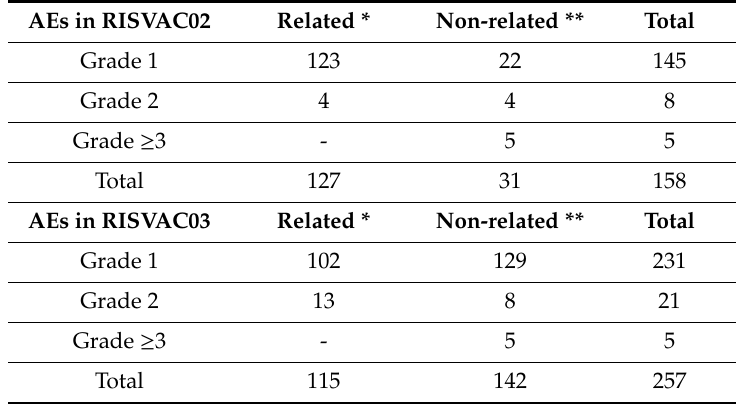
Table 1. Description of grade and relation to the vaccine of adverse events (AEs).